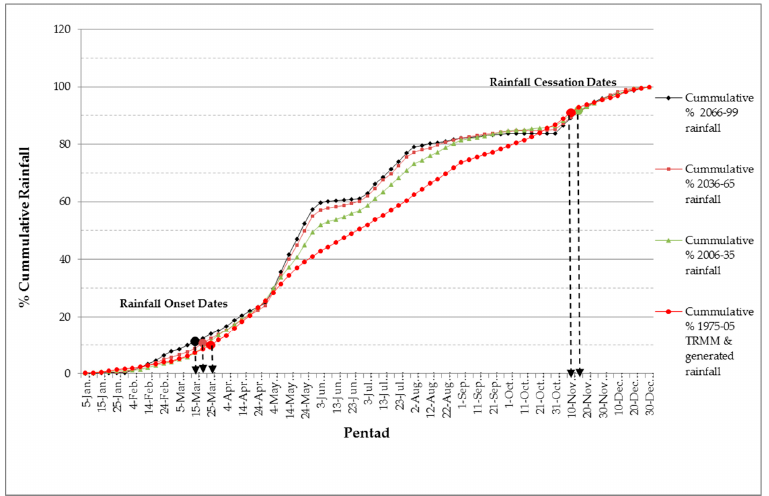
Figure 10. Kaabong Future Mean Rainfall Onset and Cessation Dates (TRMM rainfall (1975–2005) and projected (CanESM2) 2006–2035, 2036–2065 and 2066–2099.